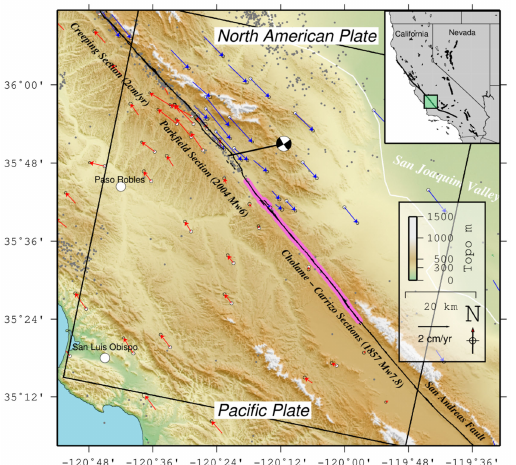
Figure 1. Location map and tectonic context. The right lateral strike-slip San Andreas Fault (SAF) trace as well as the Synthetic Aperture Radar (SAR) image acquisition geometry are presented by the black central line and the black square, respectively. The SAR presented track is the n ◦ 256, frame 2889, polarisation VV, C band. The Cholame section of the SAF is underlined in purple. The seismicity activity between 2005–2010 is presented as dark gray dots. The focal mechanism of the 2004 Mw6 Parkfield earthquake is presented. The blue and red arrows present the relative horizontal velocity between the North American Plate and the Pacific Plate recorded by the permanent GPS stations of the Central California Network between 2005–2010. The numerical elevation model is derived from the SRTM (Shuttle Radar Topography